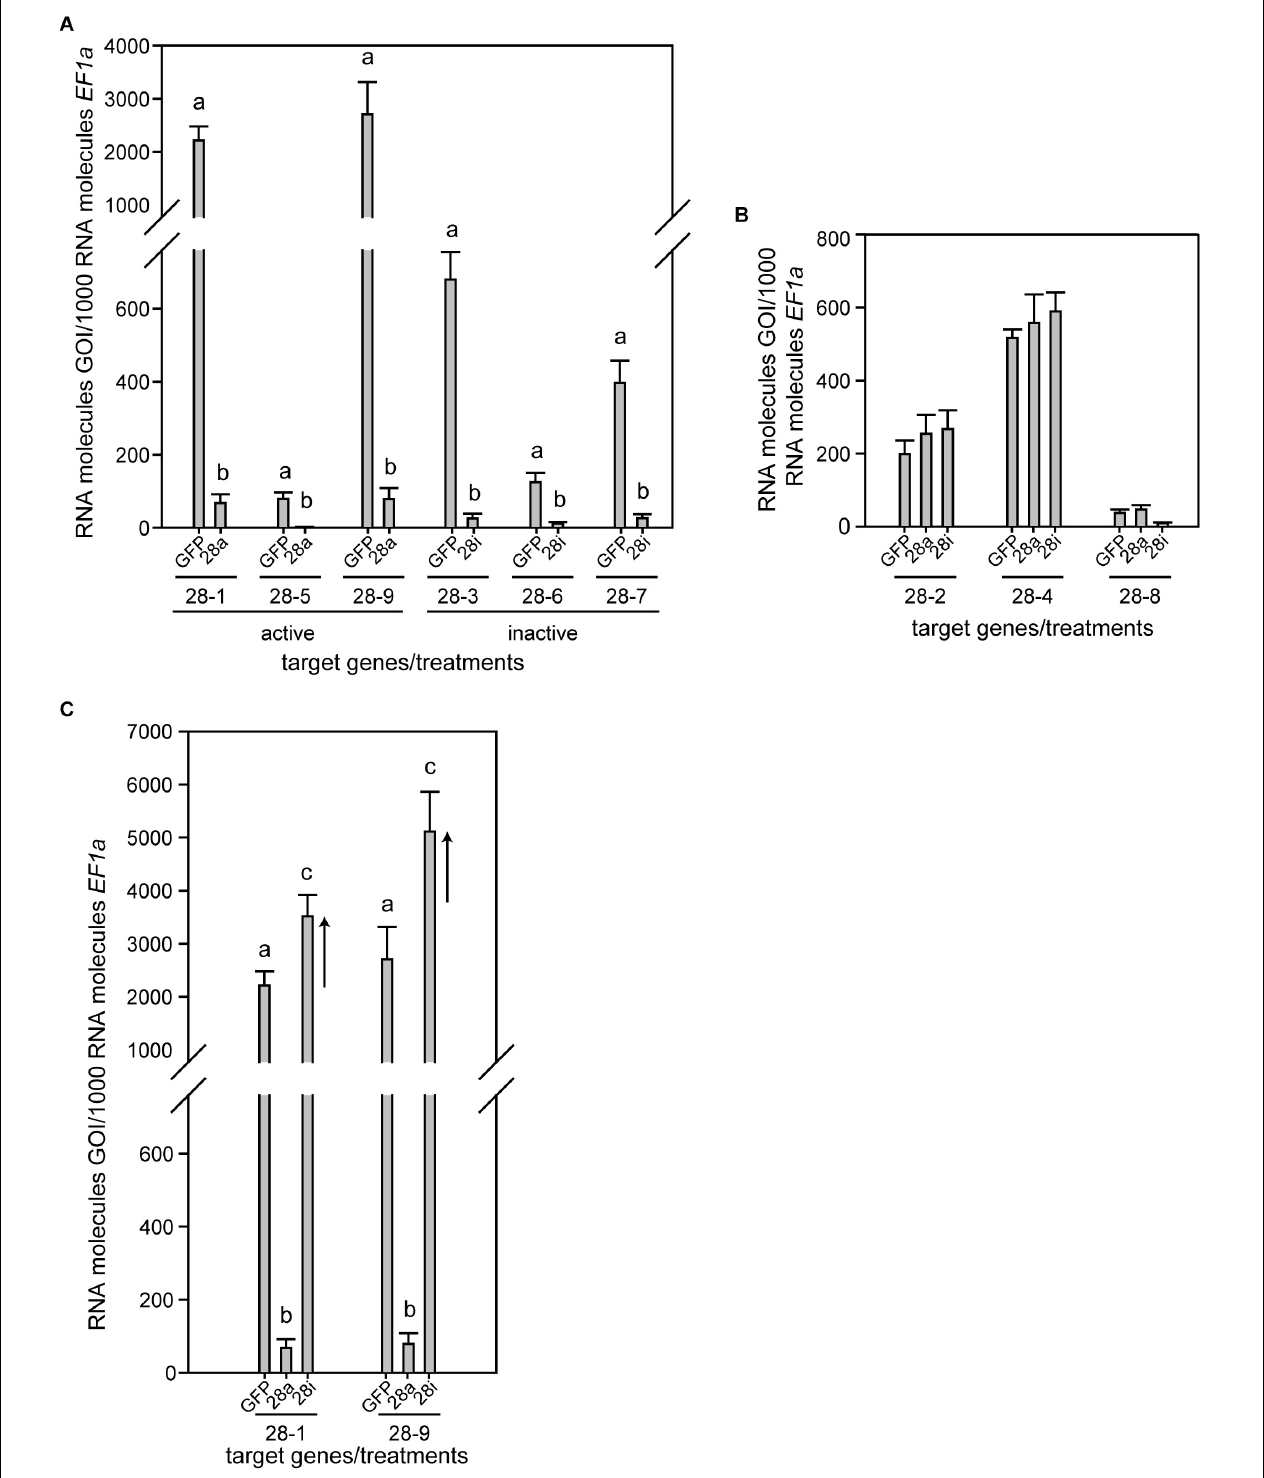
FIGURE 1 | Expression pattern of P . cochleariae GH28s comparing injection control (GFP), active GH28 silencing (28a), and inactive GH28 silencing (28i). Expression of (A) GH28 targets, (B) untargeted GH28s, and (C) the up-regulation of active GH28s when silencing their inactive GH28 counterparts. Transcript abundances are expressed as RNA molecules of gene of interest (GOI) per 1000 RNA molecules of the reference gene elongation factor 1-alpha ( EF-1 α ).